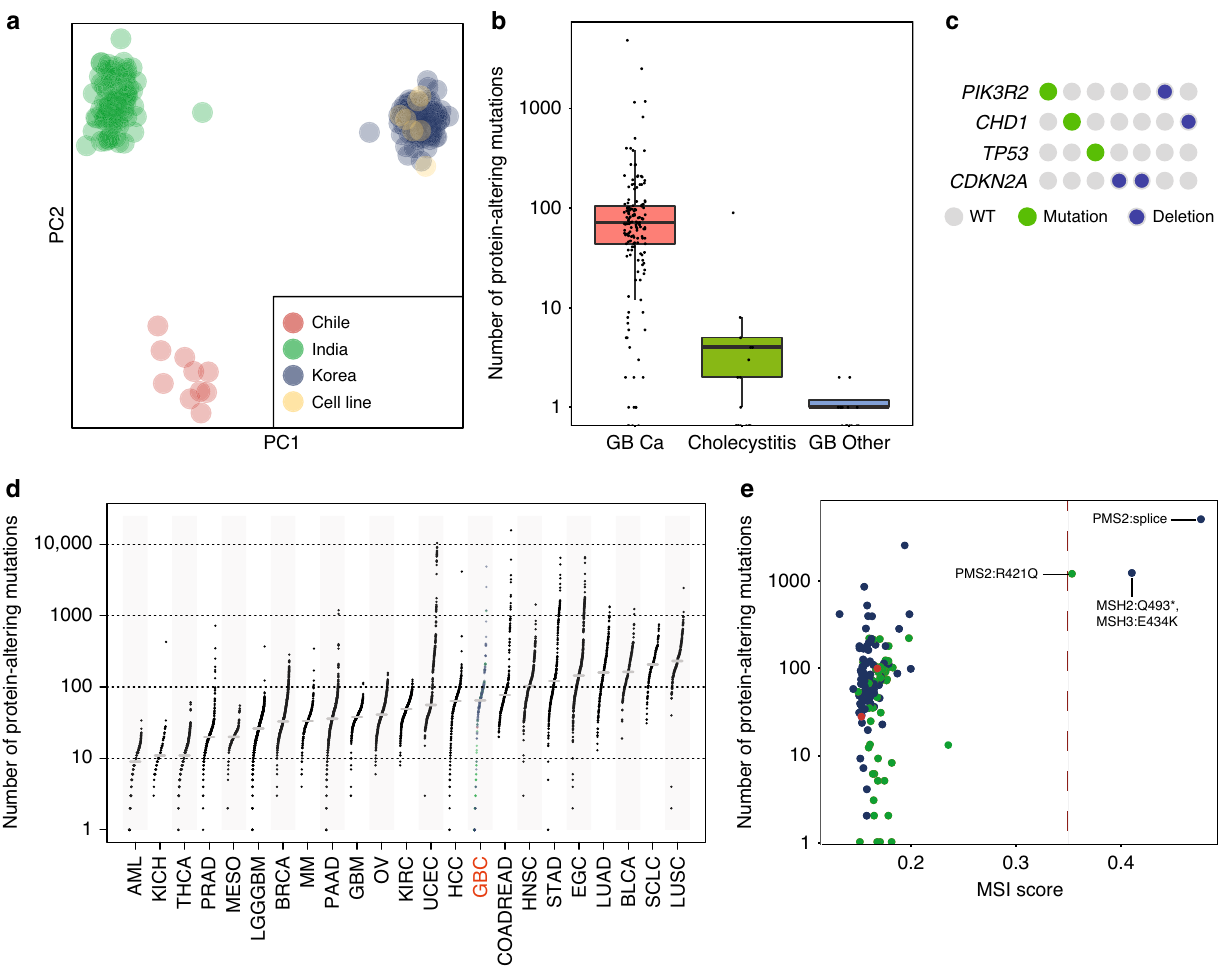
Fig. 1 Genetic variation in GBC and non-GBC samples. a Principal Component Analysis of germline variants of GBC and non-GBC samples colored based on country of origin. b Box plot depicting the number of protein-altering mutations in GBC ( n = 148), Cholecystitis ( n = 9) and GB-other ( n = 8) samples containing mutations (1 or more). Boxes indicate the interquartile range (IQR); center line, median; whiskers, lowest and highest values within 1.5x IQR from the fi rst and third quartiles, respectively. c Quilt plot showing mutations in key cancer-associated genes in cholecystitis samples. Each column represents a sample. d Number of protein-altering somatic mutations in GBC compared to mesothelioma 66 and 21 other cancer types. e MSI score determined by MANTIS plotted against the total number of protein-altering mutations for each GBC sample. Samples are colored based on country of origin as in panel a . MMR gene mutations identi fi ed are indicated next to the MSI positive